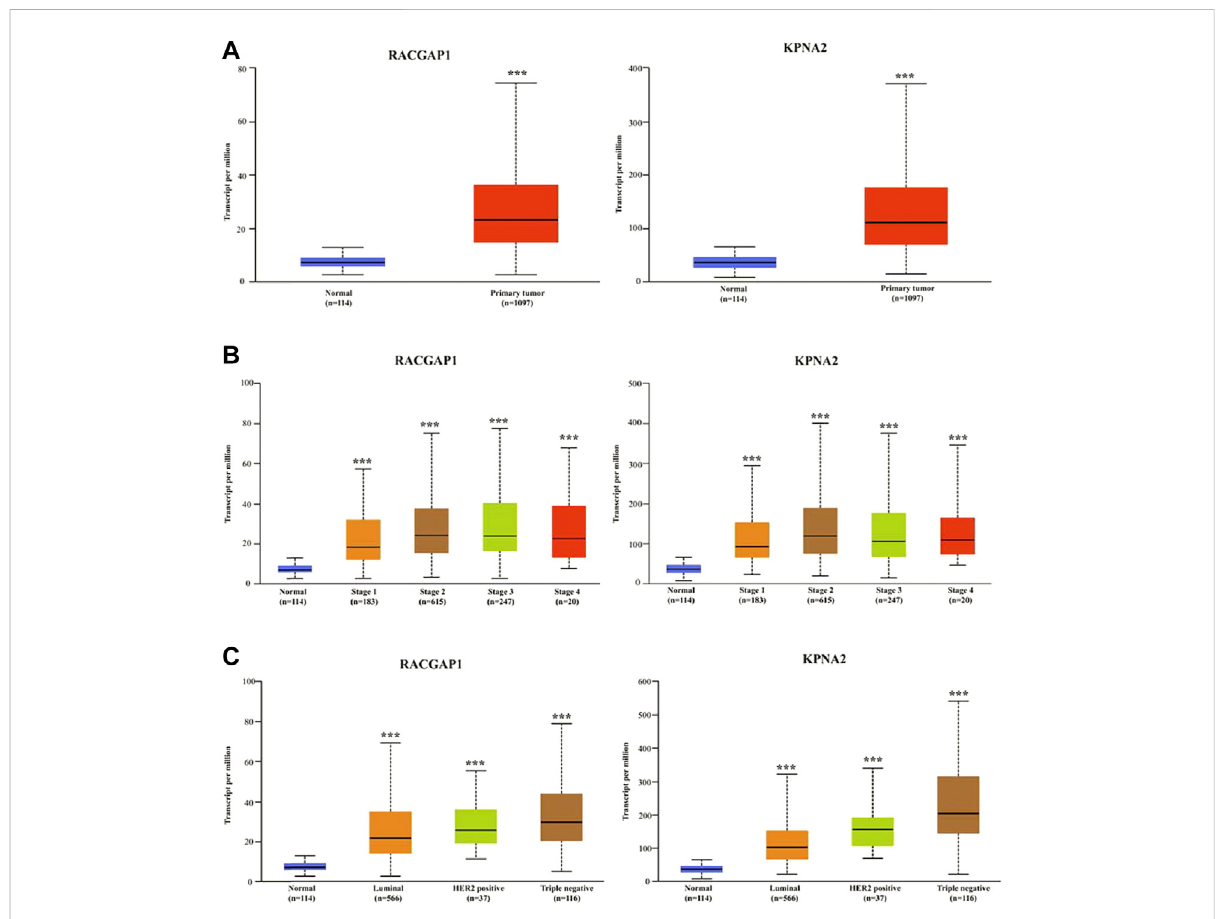
FIGURE 4 The validation of mRNA expression levels of hub genes. (A) The expression of hub genes in normal tissues and breast cancer tissues. (B) The mRNA levels of hub genes in normal tissues and breast cancer tissues at different stages. (C) The mRNA levels of hub genes in normal tissues and breast cancer tissues of different subclasses. *** p <